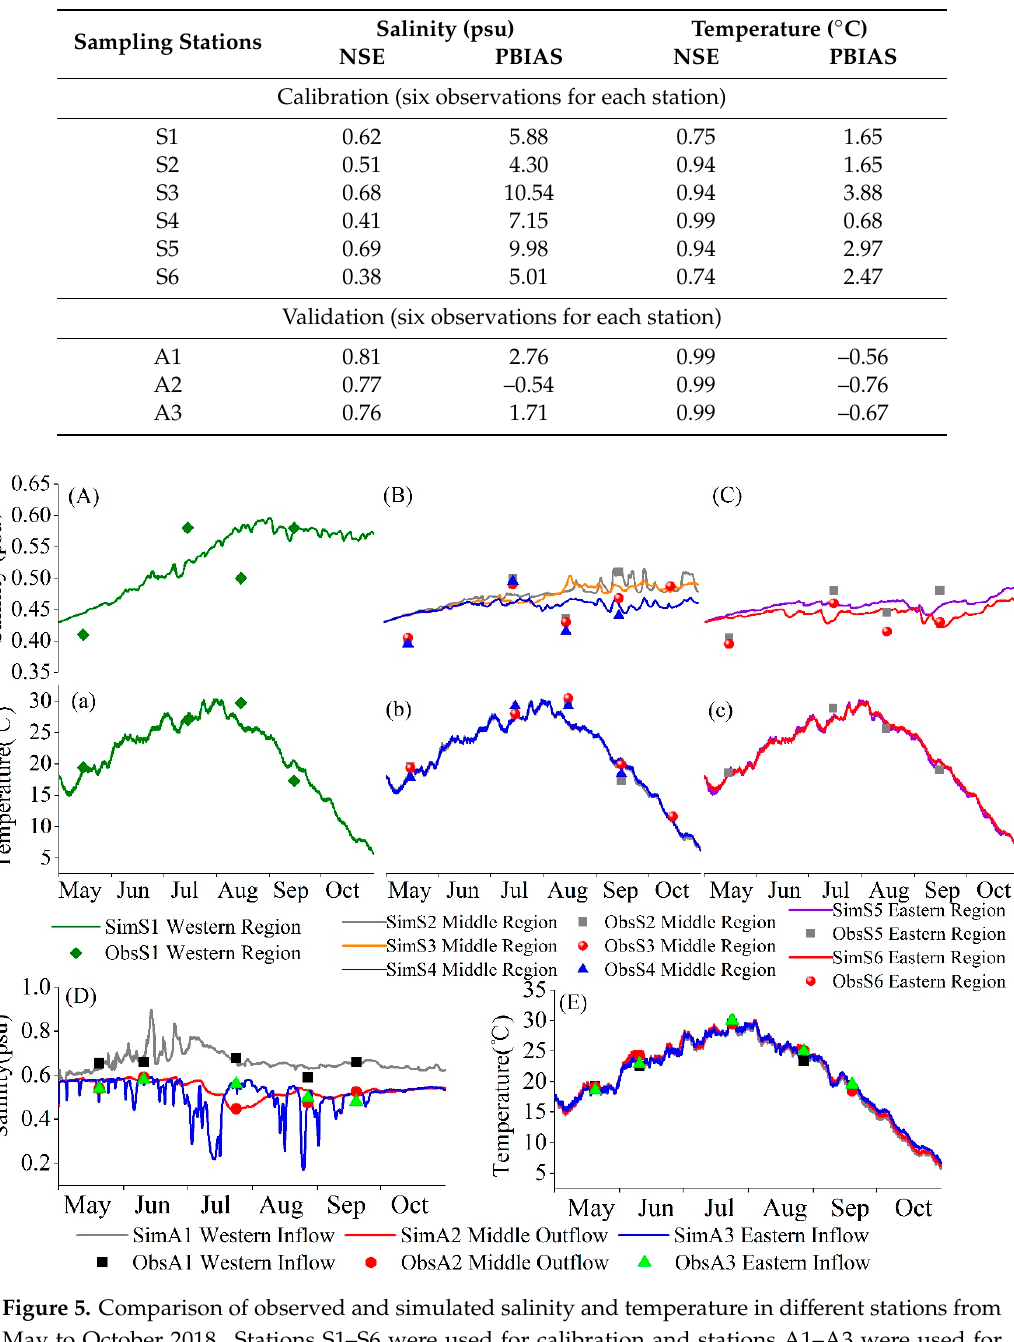
Table 4. Calibration and validation results of salinity and temperature in Chagan Lake.